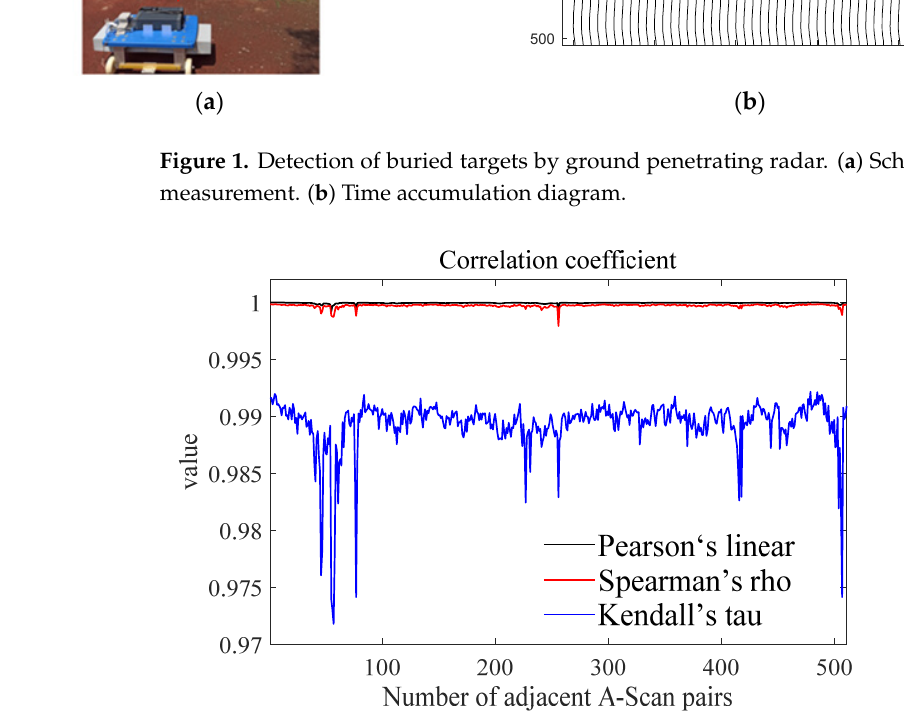
Figure 2. Correlation coefficients of the adjacent A-Scans in Figure 1.